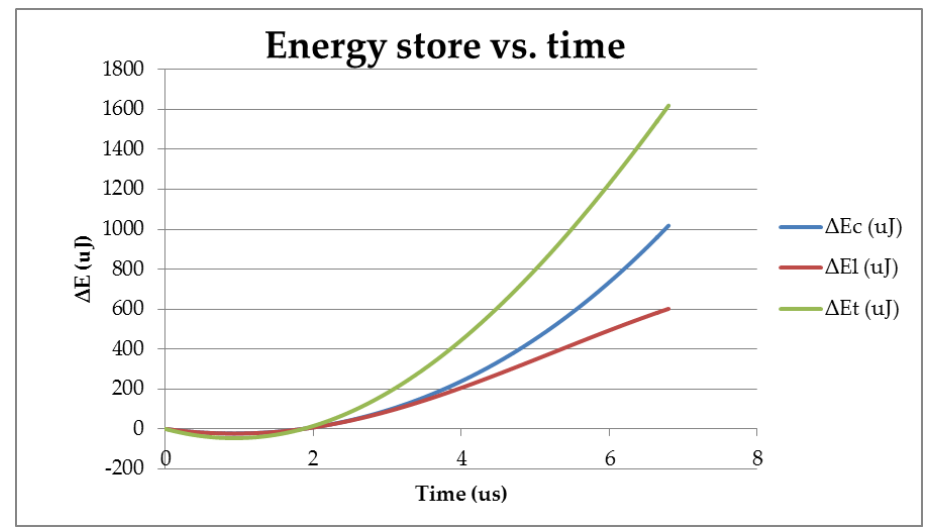
Figure 8. Energy stored in the transformer magnetizing inductance and resonant capacitor over time. ∆ Ec: increment of energy in the resonant capacitor, ∆ El: increment of energy in the primary inductance, ∆ Et: total increment of energy in the resonant tank.